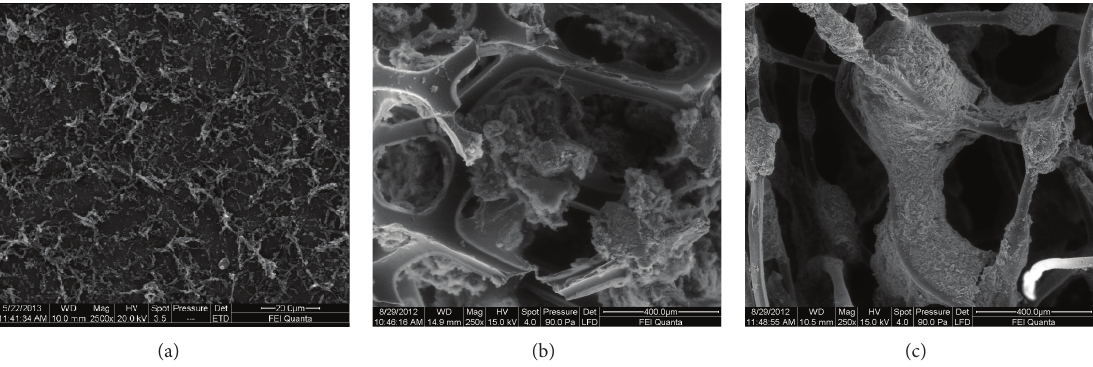
Figure 2: Scanning electron microscopy microphotographs of electroactive microorganisms grown on the anode. (a) Rolled-up graphite sheet, (b) polyurethane foam, and (c) nylon fiber.